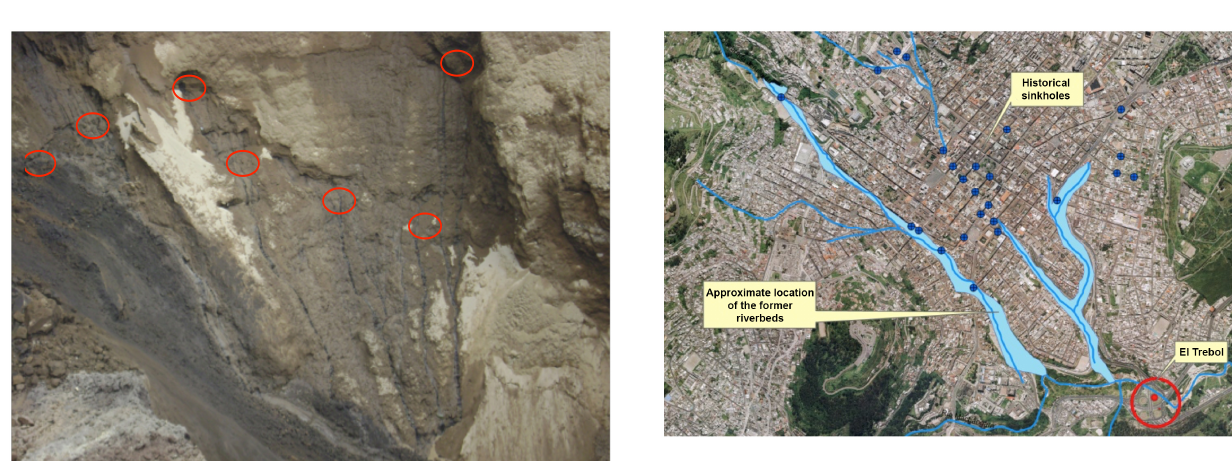
Figure 8. Historical sinkholes in the form of subsidence (blue cir- cles) at Machángara River, including the El Trébol sector (marked with the red circle and red